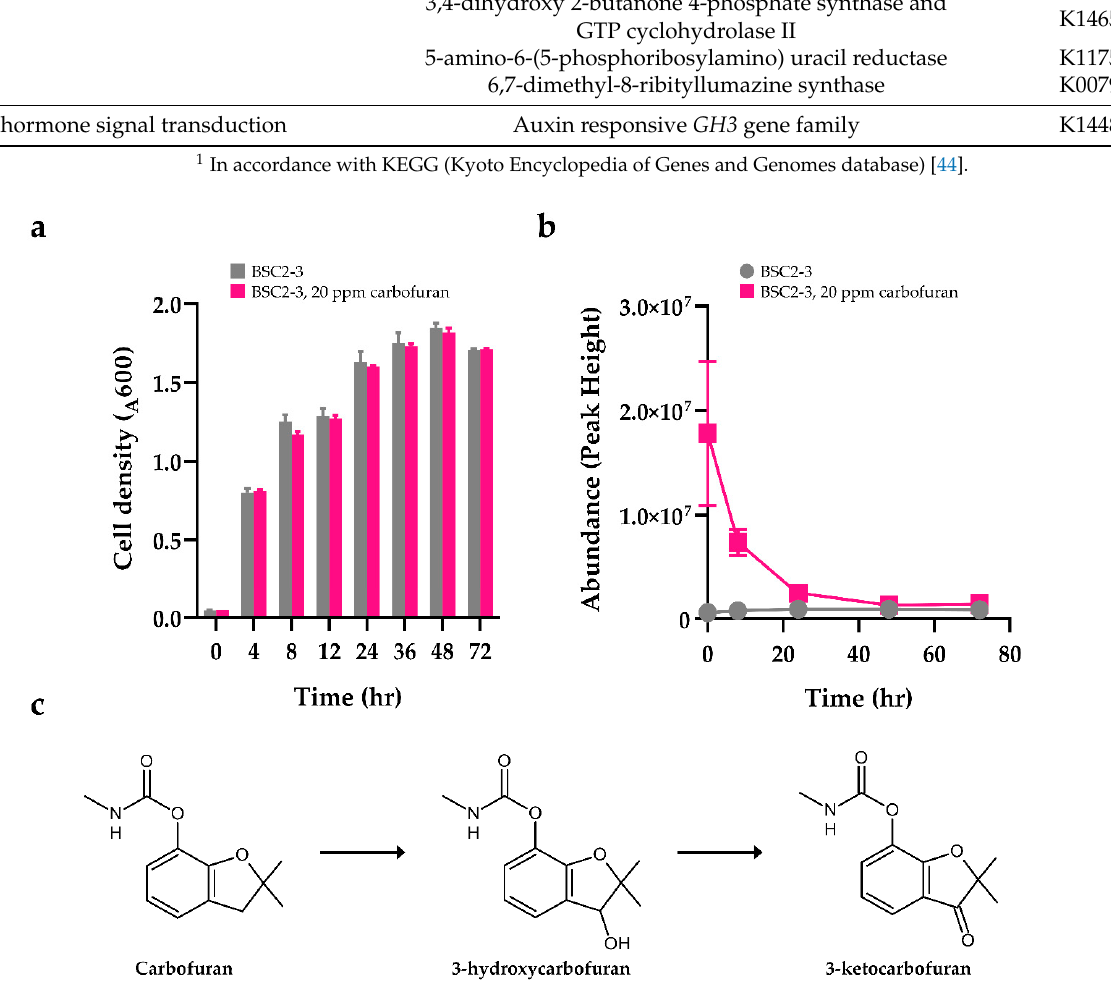
Figure 2. ( a ) Time course of cell growth (optical density at 600 nm, OD 600 ) of the BSC2 ‐ 3 strain during cultivation in R2A liquid medium with 20 ppm carbofuran. Grey bars indicate OD 600 values from the BSC2 ‐ 3 strain without carbofuran, while pink bars show cellular growth of the BSC2 ‐ 3 strain cultured with 20 ppm carbofuran. ( b ) Intracellular carbofuran changes. ( c ) Proposed carbofuran biotransformation pathway in Chryseobacterium sp. BSC2 ‐ 3.